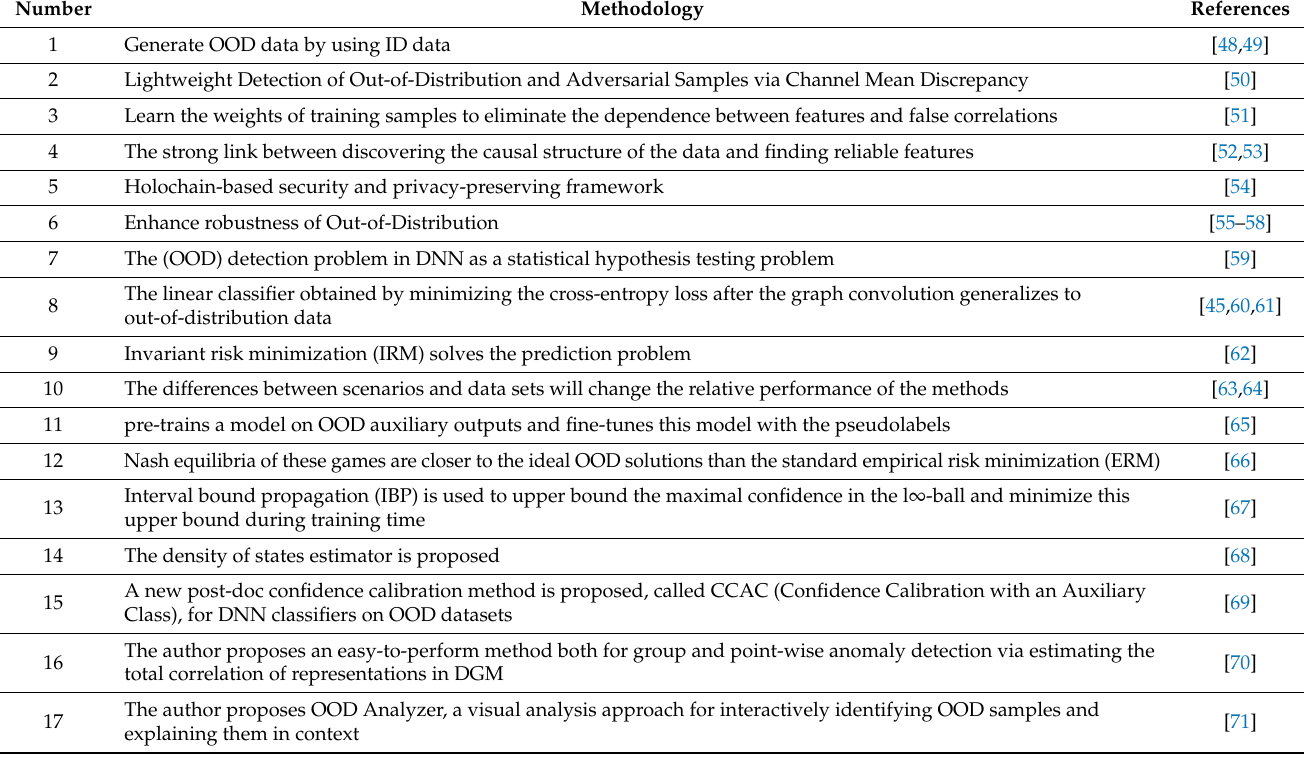
Table 1. Paper summary